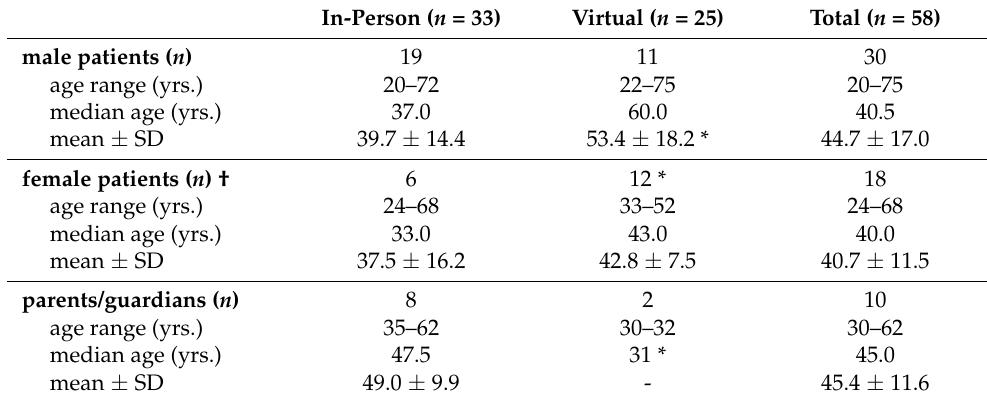
Table 1. Focus group participant characteristics ( n = 58).